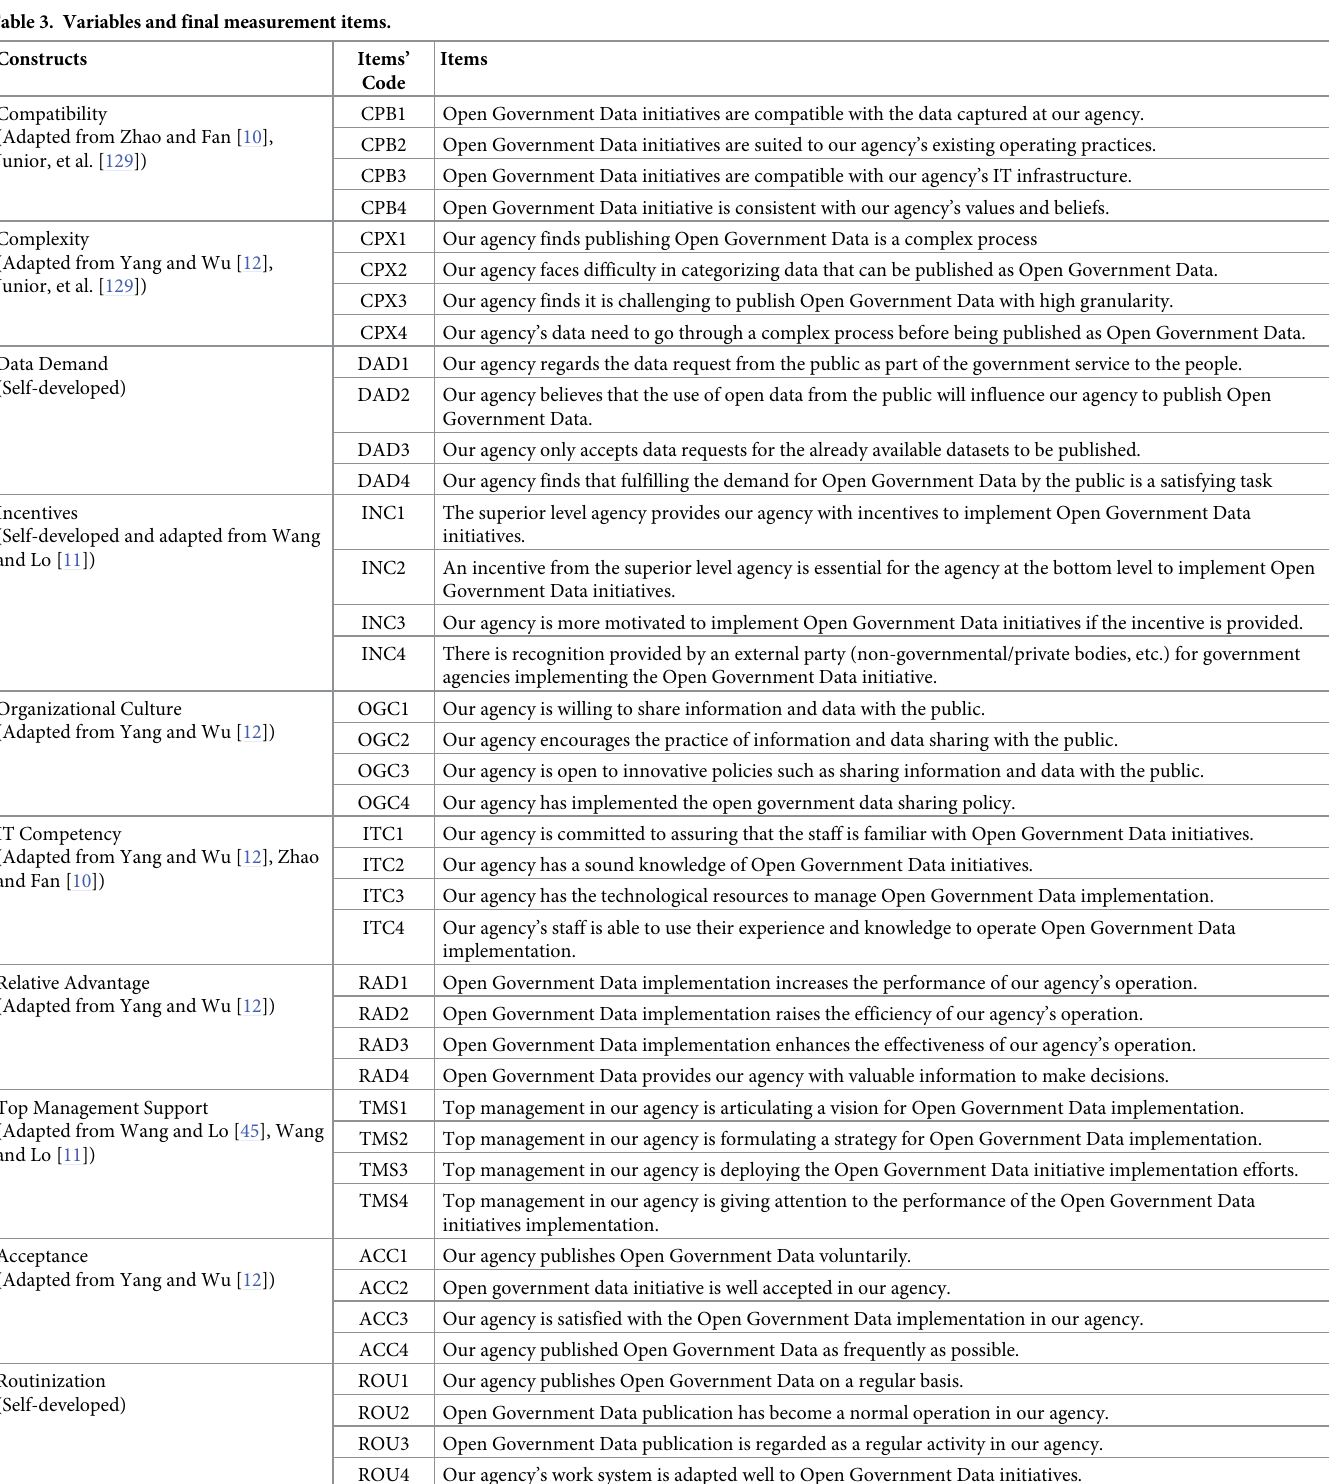
Table 3. Variables and final measurement